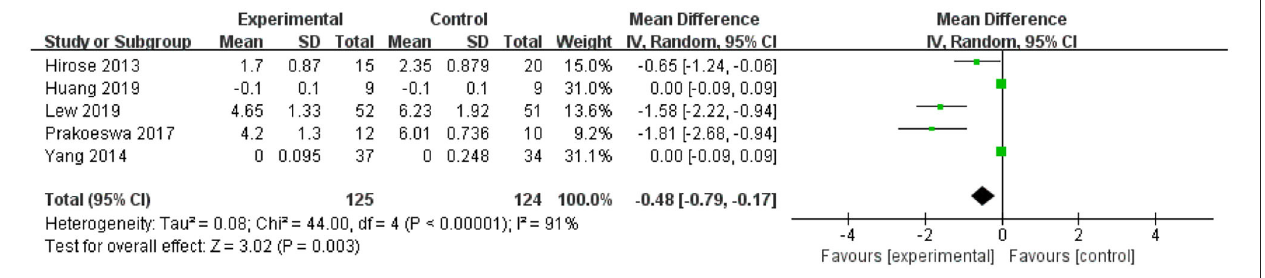
FIGURE 2 | Forest plot of effect of Lactobacillus plantarum on IL-4. SD, standard deviation; Total, sample size of each group; Mean Difference, the mean value of the experimental group minus that of the control; 95% CI, 95% confidence intervals.